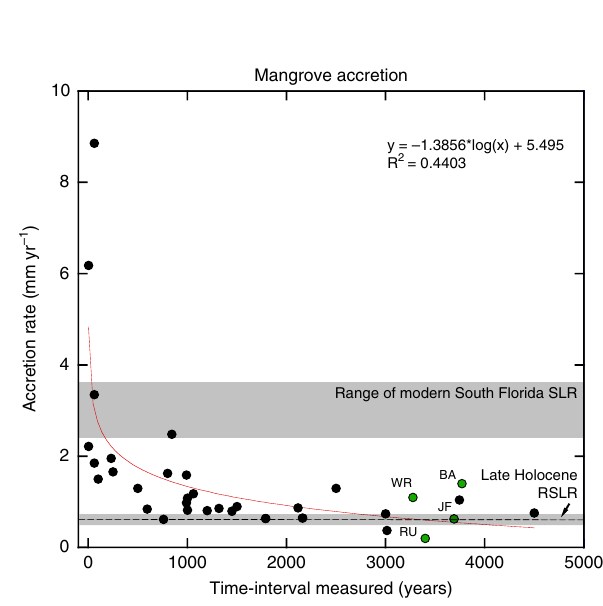
Fig. 7 Synthesis of mangrove accretion rates (black dots) across the Caribbean over the last 5.0 ka. Supplementary Table 3 lists contributing data. Red curve is a logarithmic relationship of accretion rates with time since deposition. Dashed line shows the rate of relative sea-level rise in central Florida Bay 3.7 – 2.8 ka calculated from the studied cores (shown in green). Accretion rate ages are the mean of the measured time period for which the rates were calculated. Lower gray bar indicates range of sea-level rise data based on a south Florida synthesis 1 . Higher gray bar indicates range of relative sea-level rise trends from tide gauge stations at Key West (2.42 mm yr − 1 ; 1913 – 2018) and Vaca Key (3.66 mm yr − 1 ; 1971 – 2018)